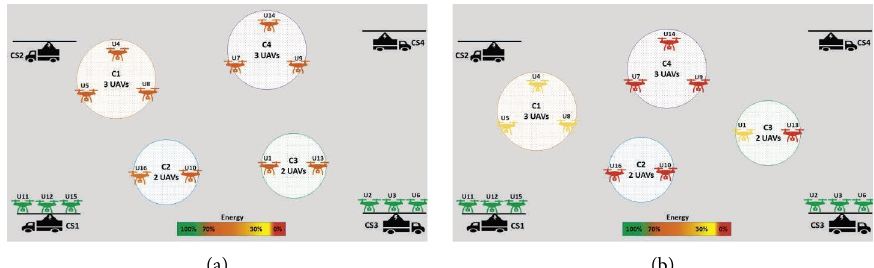
Figure 3: Simulation of the solution given by PCTs solver. (a) Solution provided by BLP-PCT 1 . (b) Solution provided by BLP-PCT 2 .